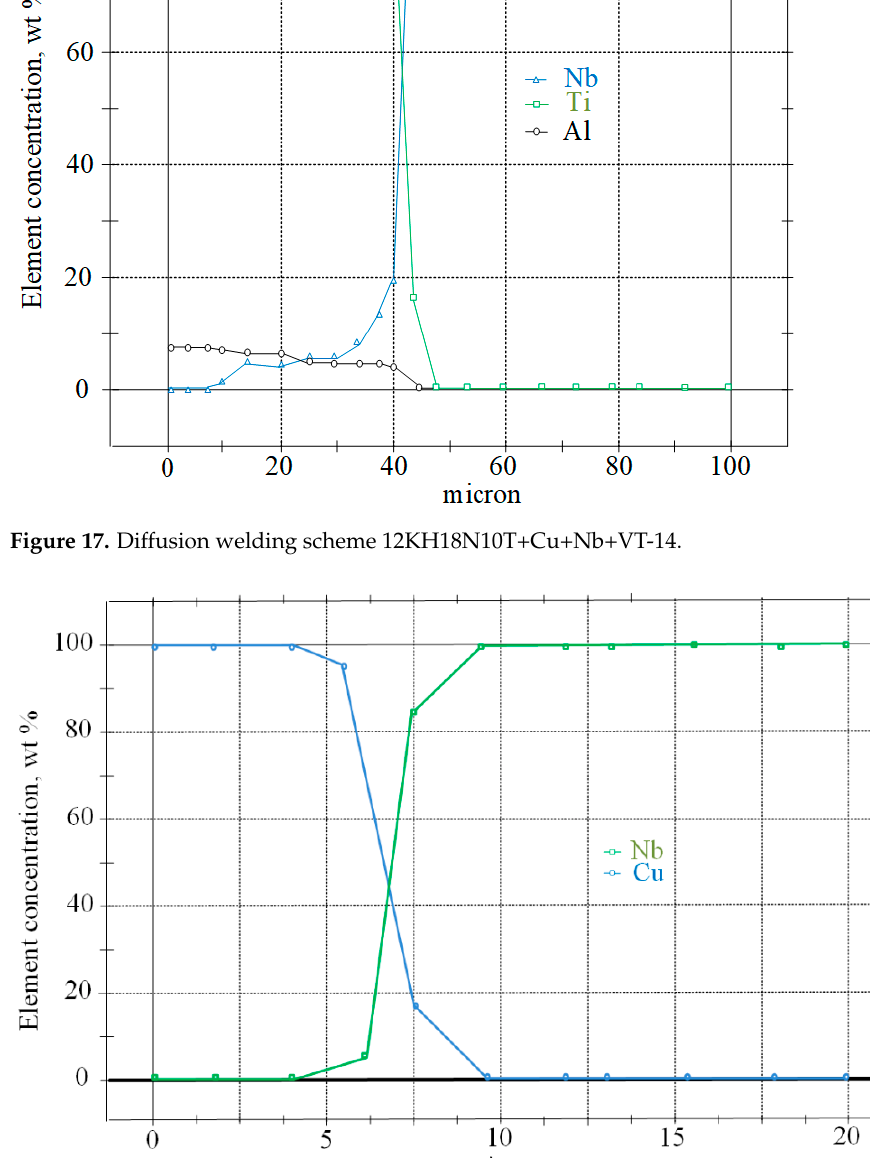
Figure 18. Diffusion welding scheme 12KH18N10T+Cu+Nb+VT-14.